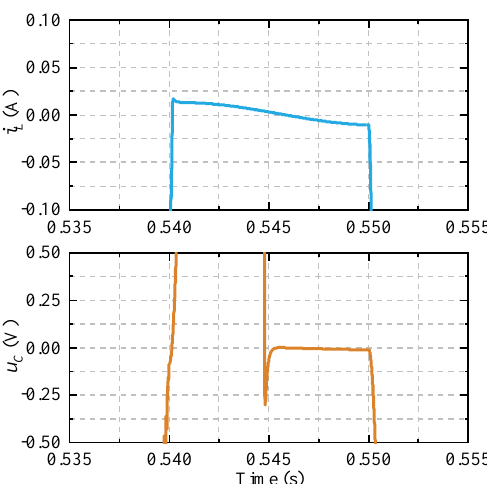
Figure 4. Dynamic details of input current and capacitor voltage waveforms at the time of S2 fault.